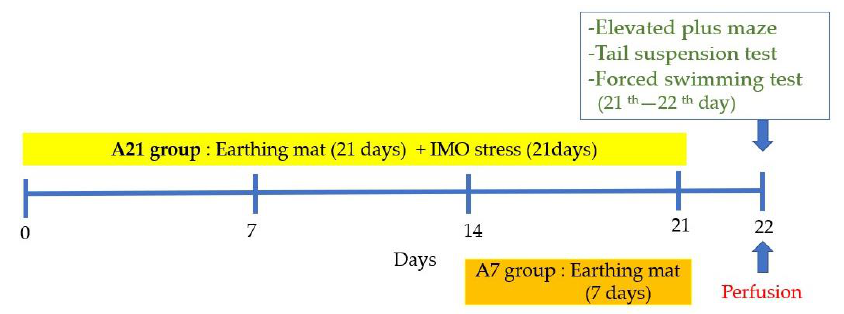
Figure 1. Experimental schedule.